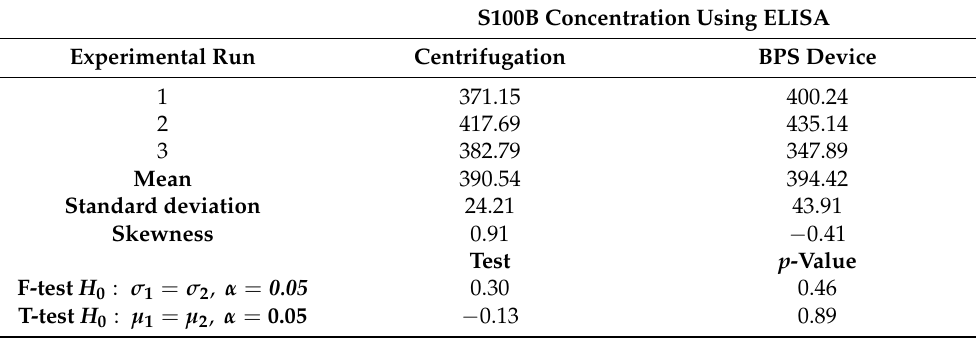
Table 4. Statistical comparison of conventional and paper-based blood plasma separation for measur- ing S100B at 562 pg/mL using ELISA.